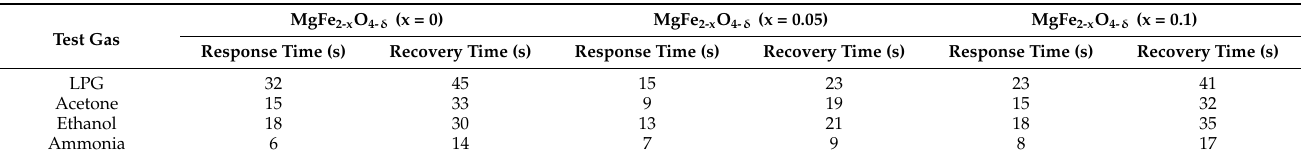
Table 3. Response and recovery times of stoichiometric and non-stoichiometric sensor materials toward mentioned reducing